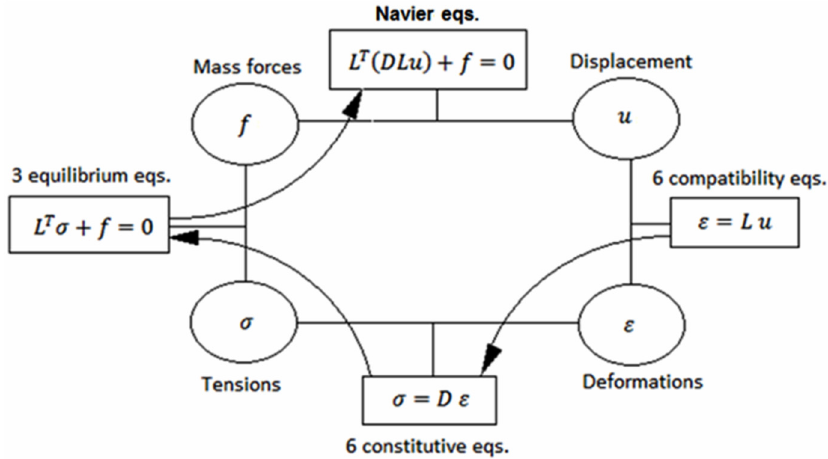
Figure 7. Navier formulation (adapted from